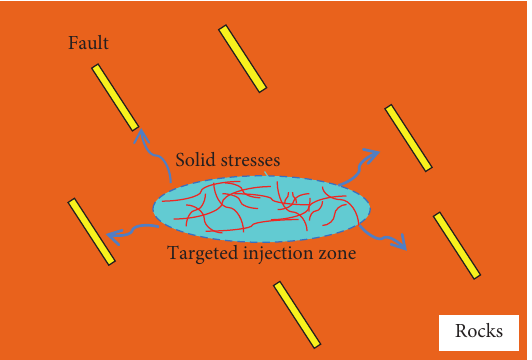
Figure 2: Schematic of injection zone and its surrounding faults.